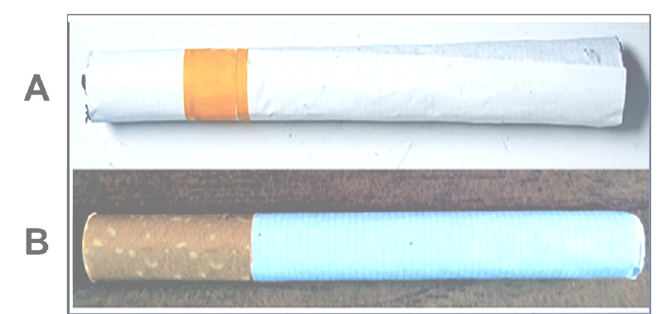
Figure 1. Cigarettes used to prepare condensate cigarette smoke. A and B are Clove and non-clove cigarette,